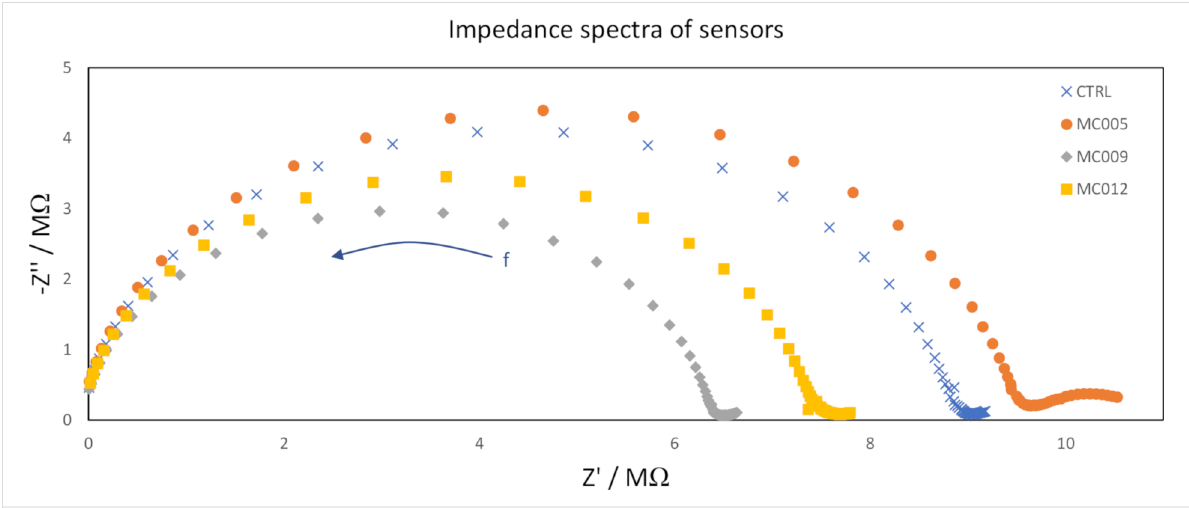
Figure 7: Impedance spectra of sensors with each of the membranes. The spectra were recorded in 0.1 M sodium acetate in the frequency range 100 mHz to 100 kHz at open-circuit potential.